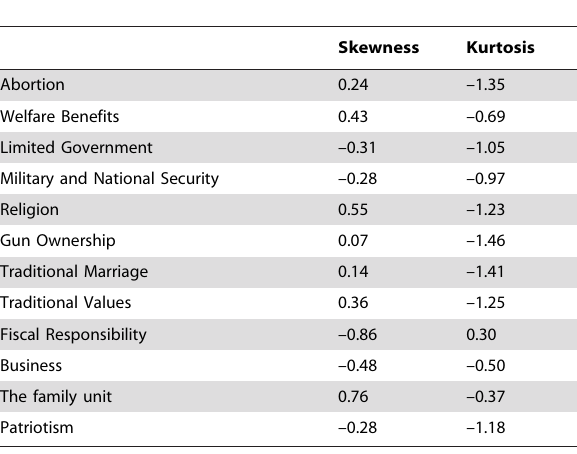
Table 5. Skewness and Kurtosis of the 12 SECS